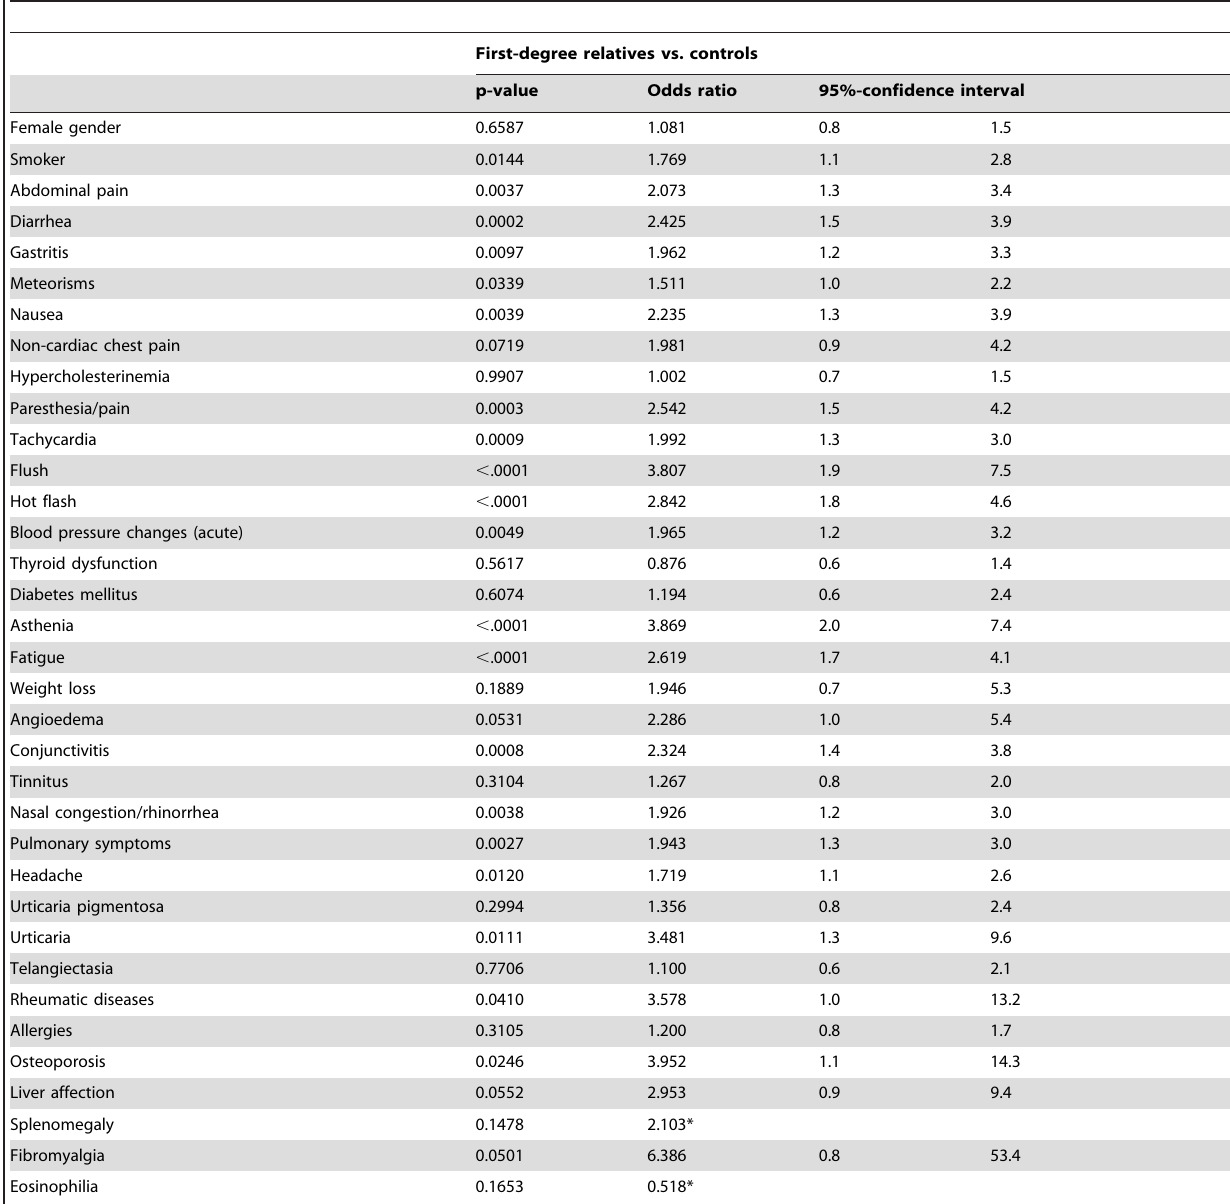
Table 4. Odds ratios for the symptoms and findings collected in the questionnaire (independent variables) occurring in first- degree relatives, compared with the healthy control